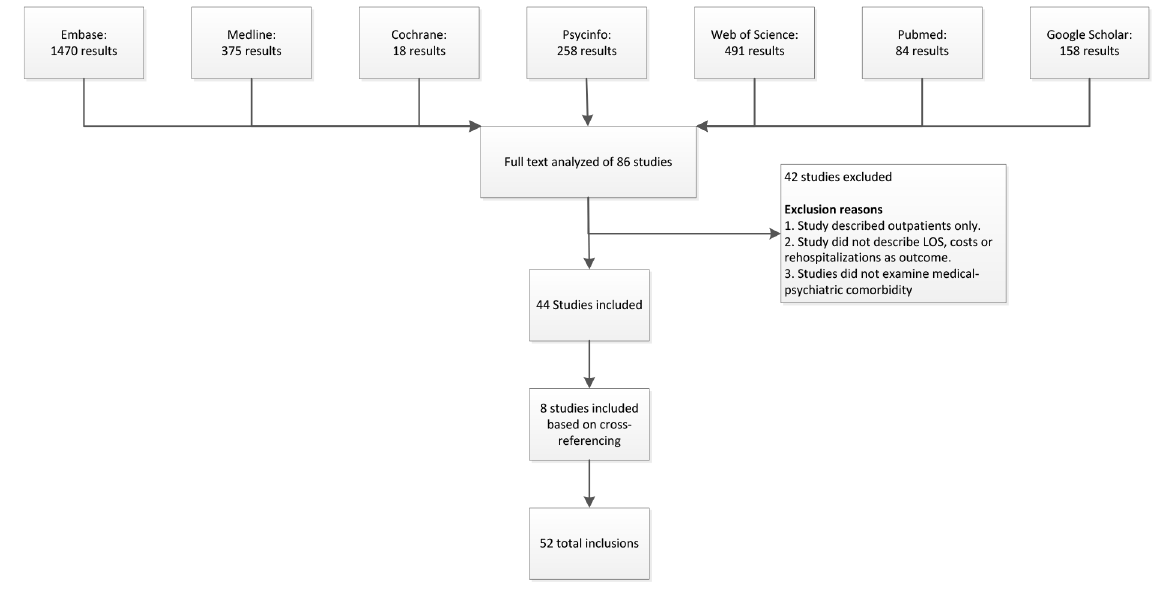
Fig 1. Flowchart of study